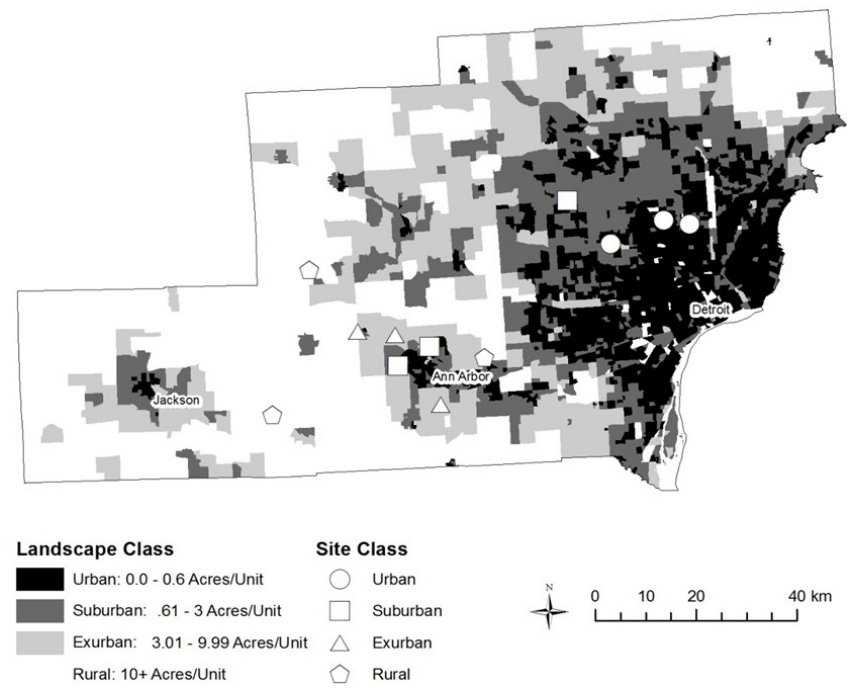
Figure 1. Map of Housing Density, Major Cities, and Site Locations. Housing density in census block group resolution is shown, with the three major metropolitan areas and site locations used in the present study. Acres/Unit refers to average acres per US Census Bureau housing unit within each census block (1 acre/unit = 0.4 hectare/unit). Shapes of site symbols represent housing density classification used in the present study